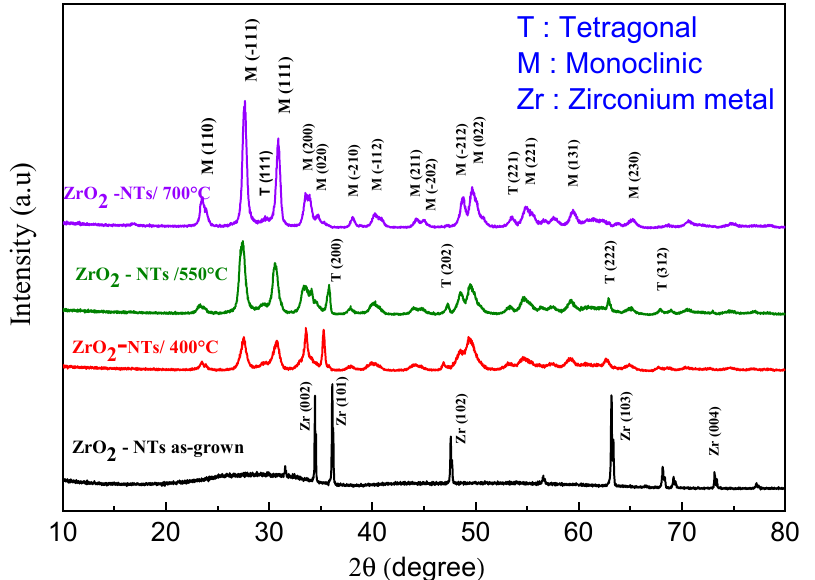
Figure 4. X-ray diffraction patterns of the as-grown and air-annealed ZrO 2 NTs at different temperatures (400 °C, 550 °C, and 700 °C).